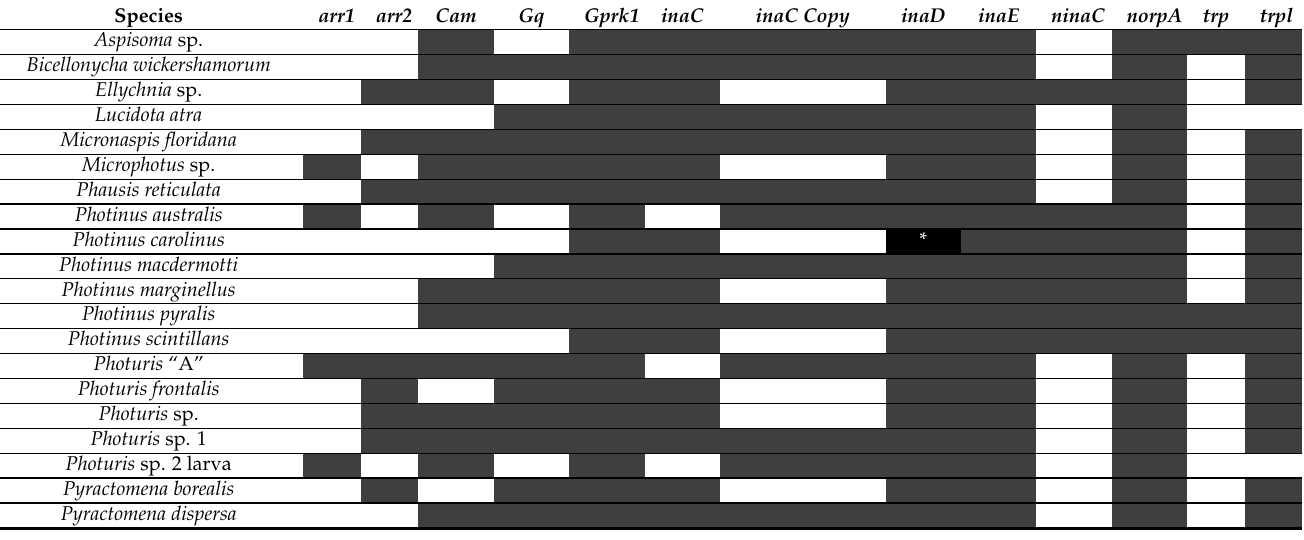
Table 1. Presence/absence data for genes sampled in the phototransduction pathway. Gray box indicates presence. * indicates presence of duplication in Photinus carolinus only.